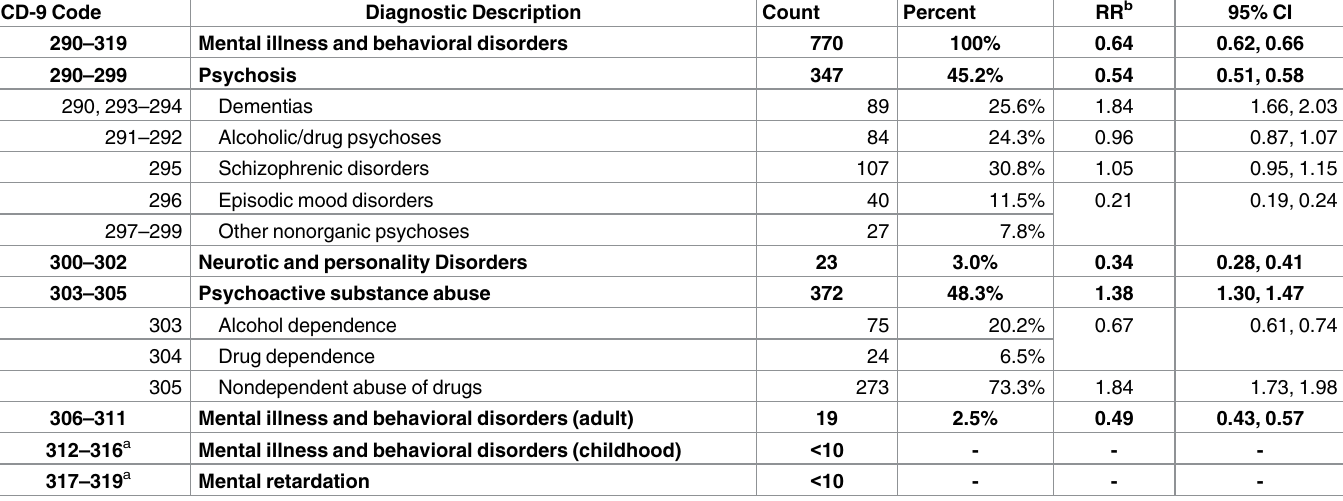
Table 2. Counts and risk ratios (RRs) of hospitalizations due to a primary or secondary diagnosis of MBD with a concurrent HRI diagnosis, United States, 2001–2010(Summer). ICD-9